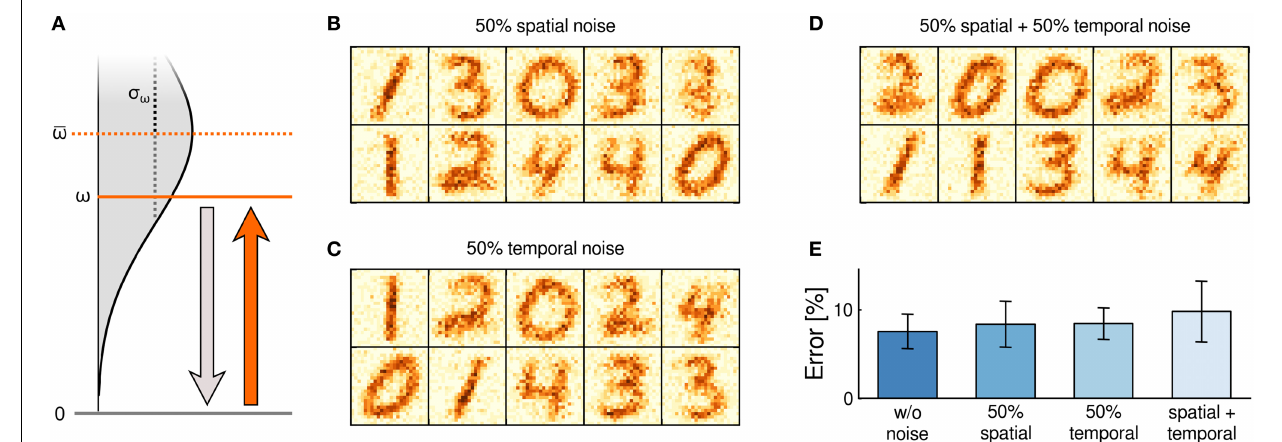
FIGURE 5 | Robustness to spatial and temporal noise. (A) Noise was added by drawing the weight ω of the active state from a normal distribution. Three types of noise were tested: For spatial noise, a value ω ∼ N ( ω ; ¯ ω,σ 2 ω ) was assigned to each switch and maintained throughout the experiment. For temporal noise, the value ω was redrawn after every LTP transition. For spatial + temporal noise, the